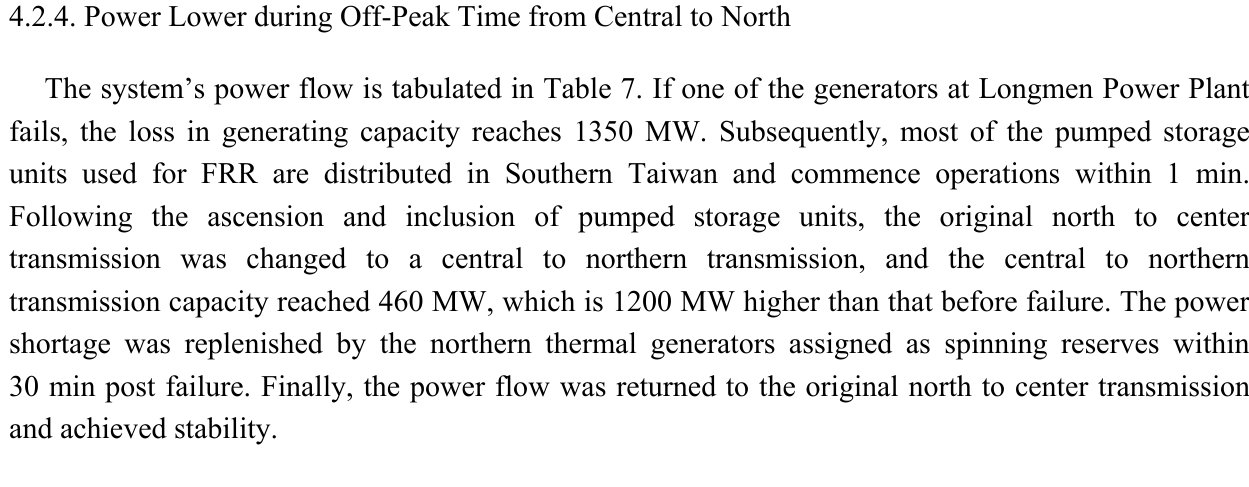
Table 7. Comparison between the central to northern power flow capacities post failure for off-peak time in